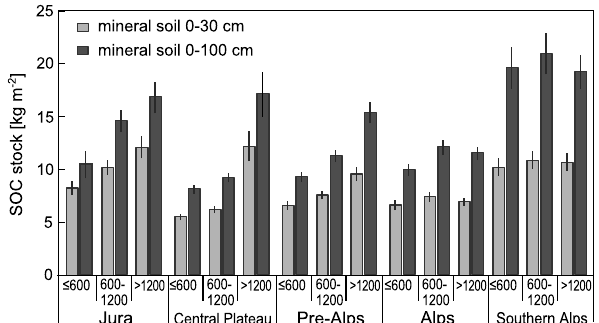
Figure 6. Block kriging predictions of the soil organic carbon (SOC) stocks in 0–30cm and 0–100cm soil depth in the five ecore- gions stratified by altitude a.s.l. (m) into three classes (vertical lines: prediction